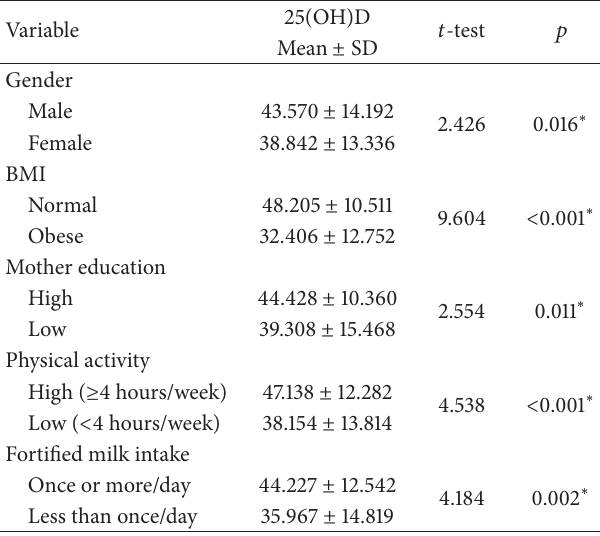
Table 1: Serum 25(OH)D levels related to presumed risk factors for vitamin D insufficiency.